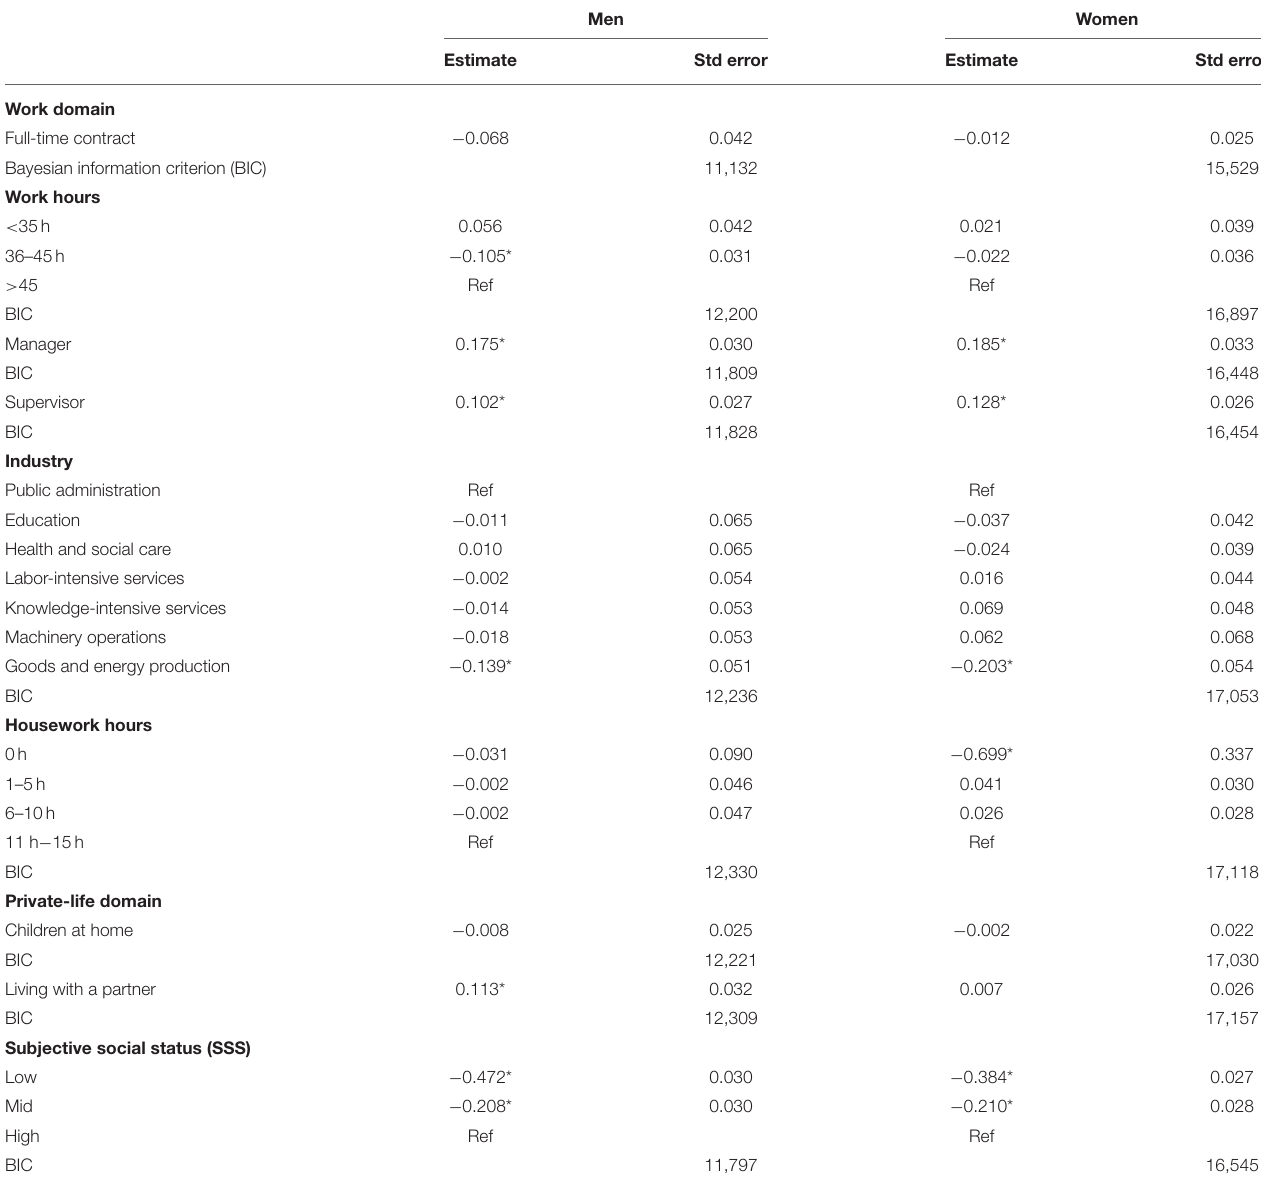
TABLE 1 | Linear mixed model for men and women separately for the likelihood of reporting work-life enrichment